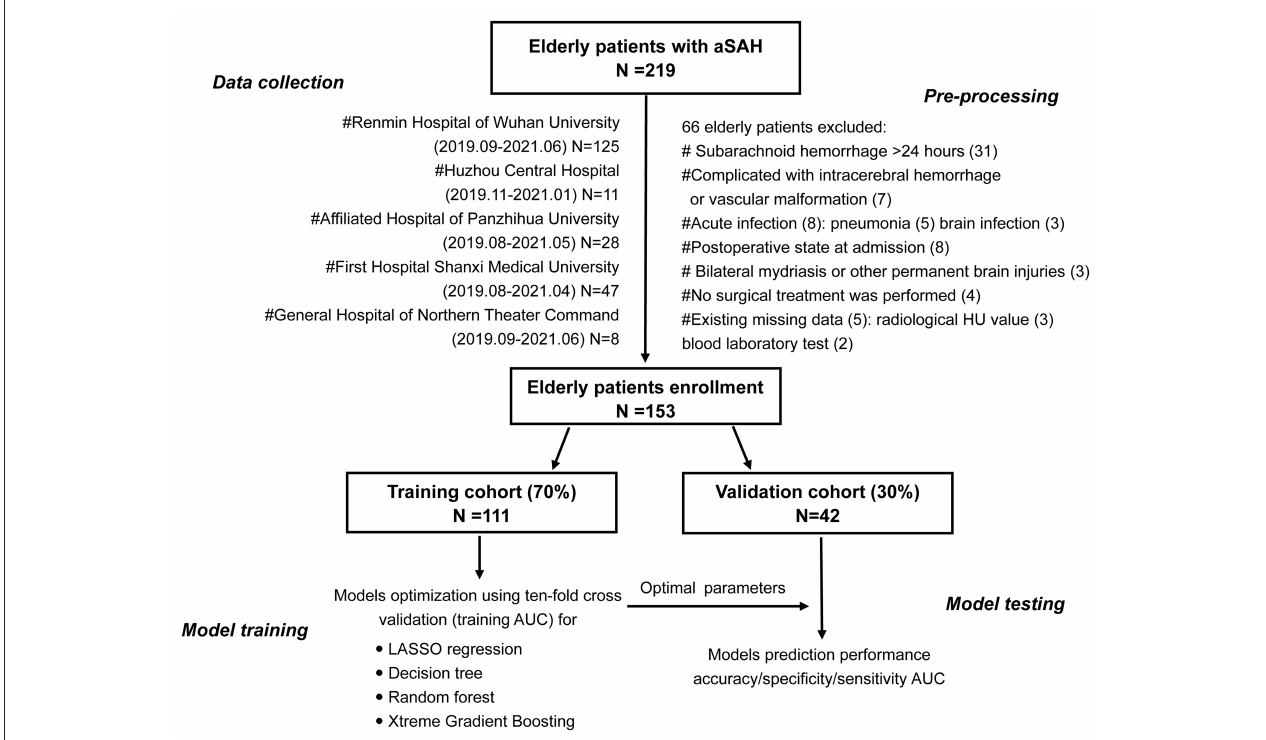
FIGURE 1 | The flowchart that showed exclusion details and the procedure of this